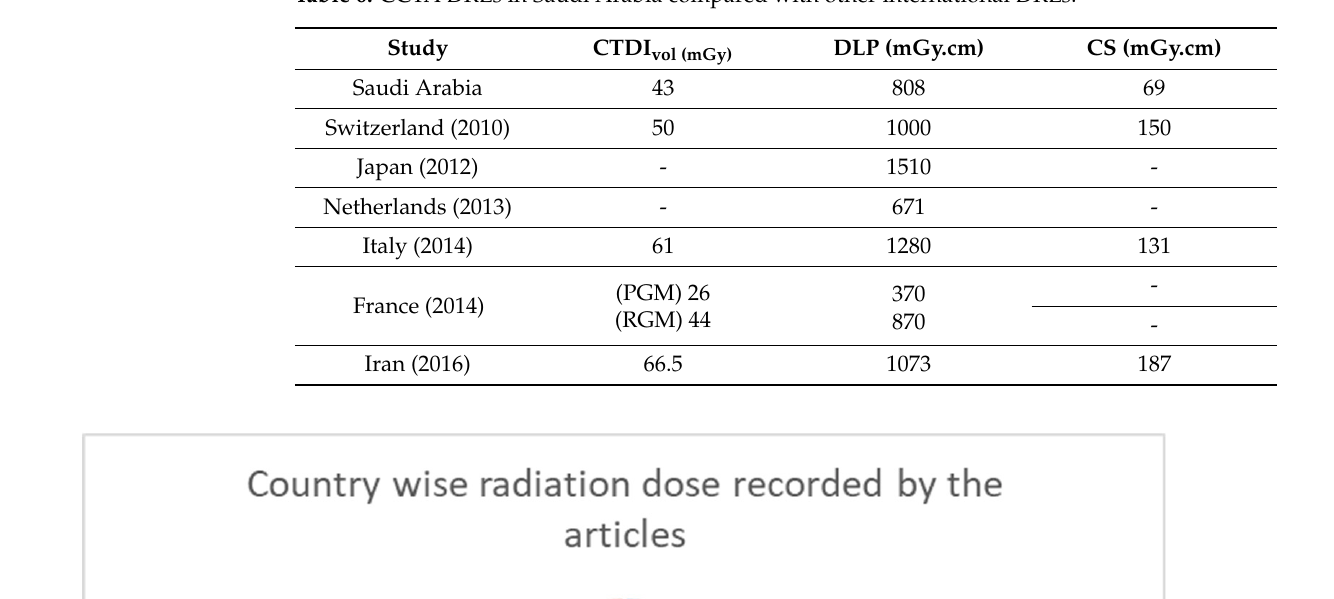
Table 6. CCTA DRLs in Saudi Arabia compared with other international DRLs.